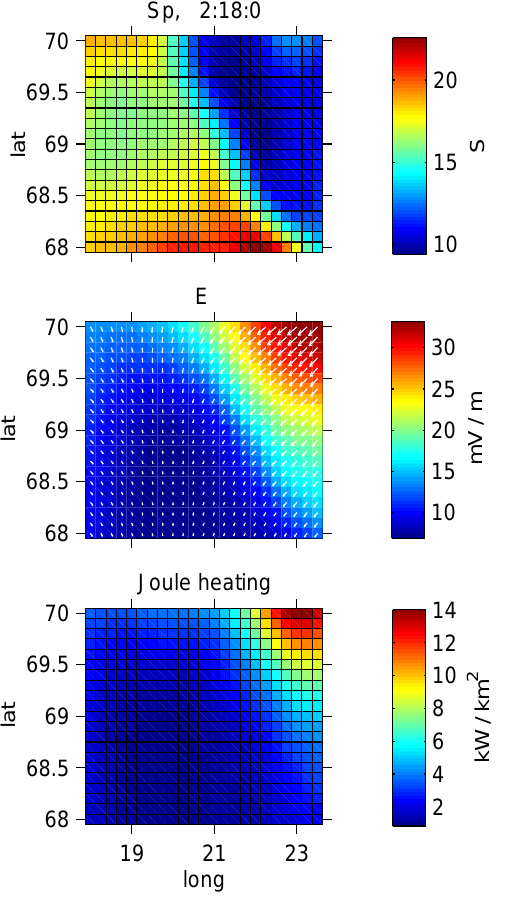
Fig. 13. From top to bottom: The Pedersen conductance, elec- tric field (vector field and magnitude) and Joule heating E · J . This snapshot corresponds to the situation illustrated in Fig. 8